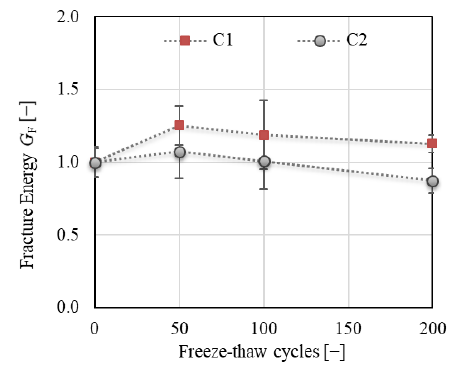
Figure 11. Specific fracture energy G F .